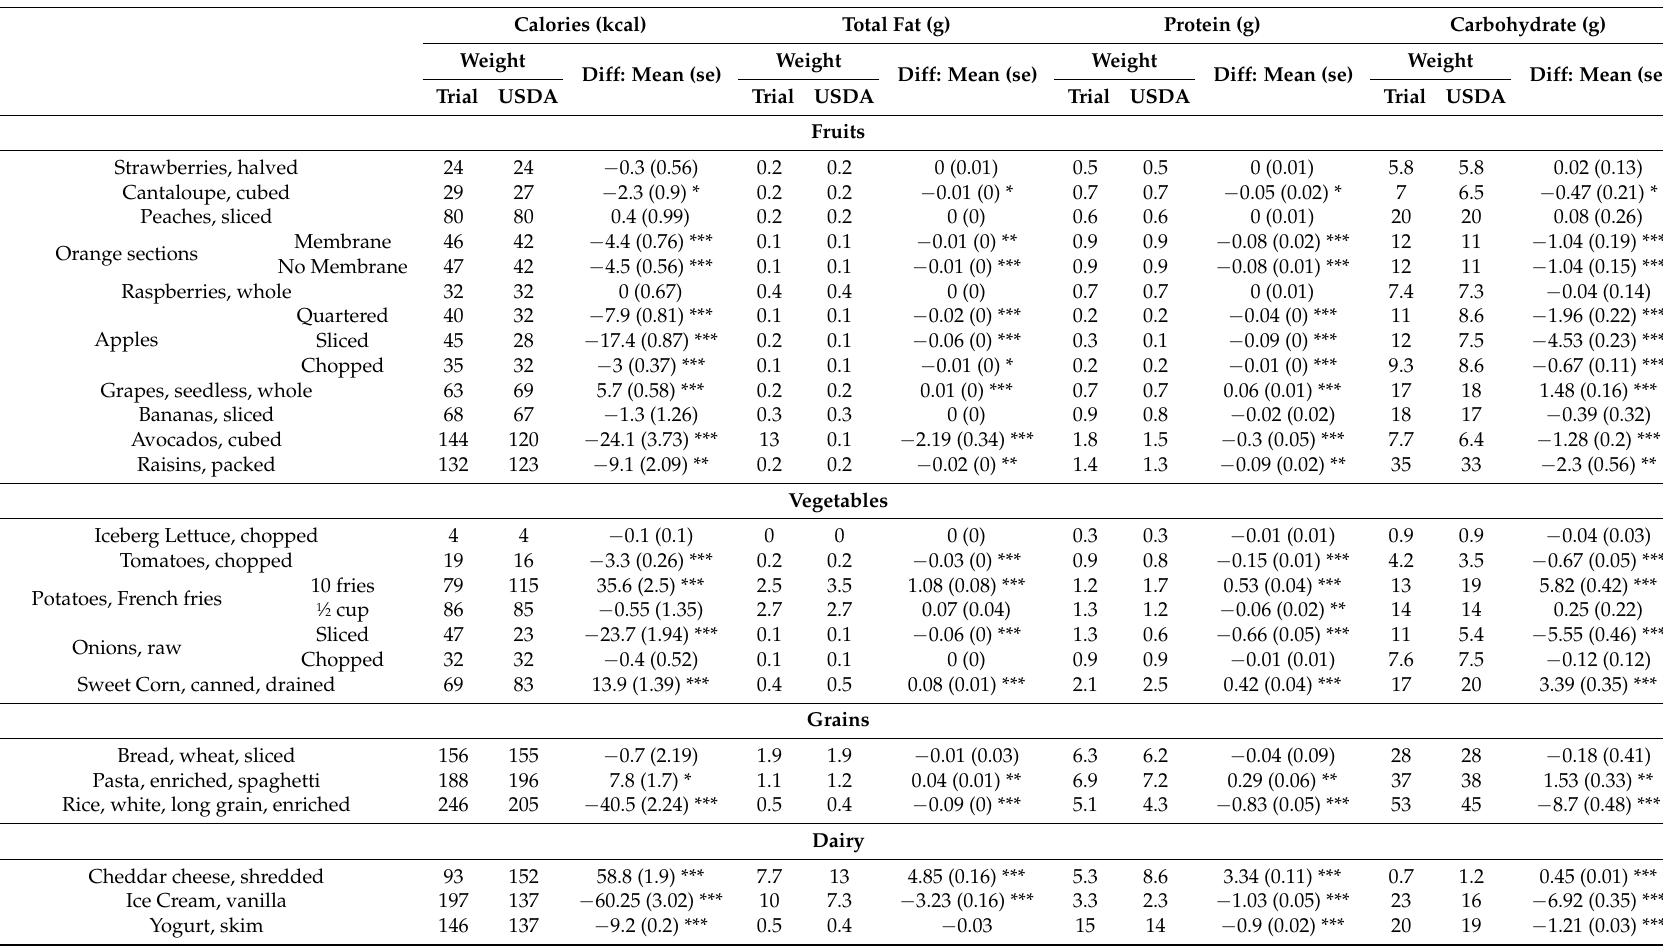
Table 3. Mean macronutrient values obtained from USDA-SR 28 based on trial volume and USDA volume and their differences (USDA Volume–Trial